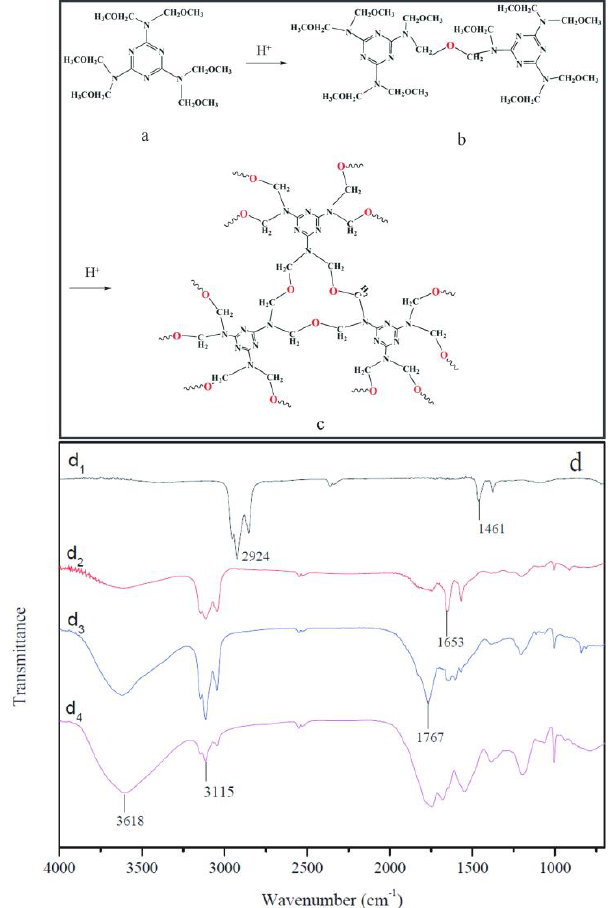
Figure 4. Chemical structure of microcapsule samples, ( a – c ) chemical sketch of HMMM polymerization process: ( a ) HMMM prepolymer, ( b , c ) the networks of cross-linked HMMM; ( d ) FT-IR spectra of microcapsule samples: (d 1 ) rejuvenator, (d 2 ) self-healing microcapsules (MG-0) without graphene, (d 3 ) self-healing microcapsules (MG-2) with 2% of graphene, and (d 4 ) self-healing microcapsules (MG-10) with 10% of graphene.